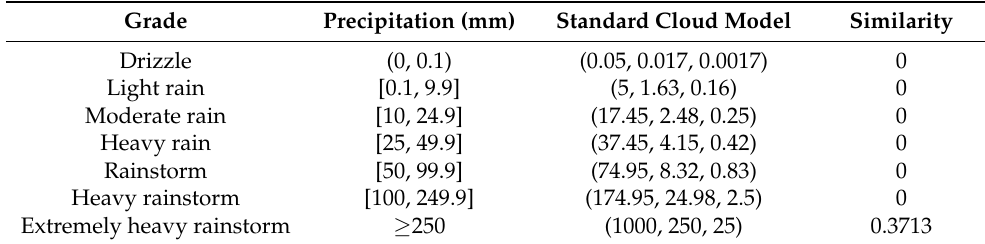
Table 1. Information about